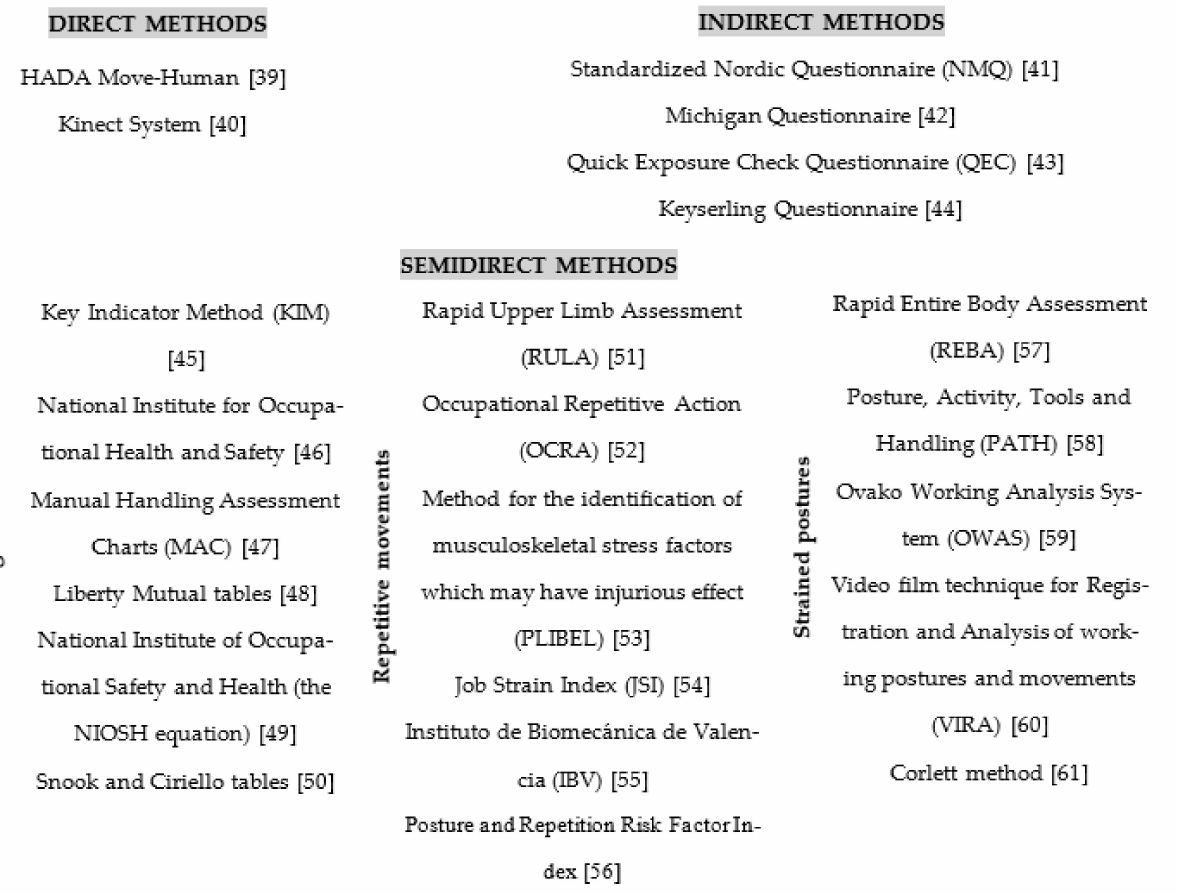
Figure 2. Some examples of MSD assessment methods